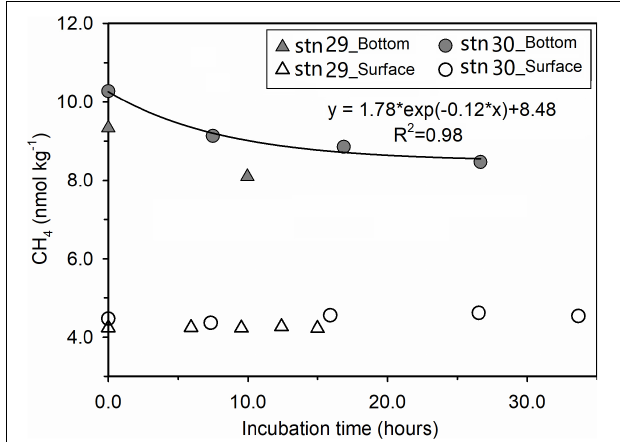
FIGURE 4 | Evolution of [CH 4 ] during our field incubation experiments. Filled and open triangles stand for bottom waters and surface waters collected from station 29, while filled and open circles are for those from station 30. The solid line is the best fit of data for the bottom water from station